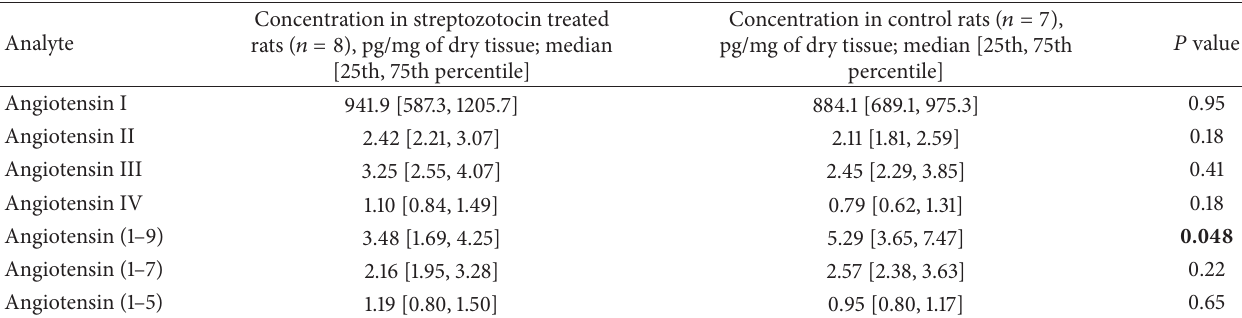
Table 2: Concentrations of the products of metabolism of exogenously added (to a final concentration of 1 𝜇 M) angiotensin I by the aorta fragments pretreated with perindoprilat (final concentration 3 𝜇 M) from streptozotocin and saline treated animals (pg/mg of dry tissue; median [25th, 75th percentile]). 𝑃 values are from Kruskal-Wallis nonparametric tests.